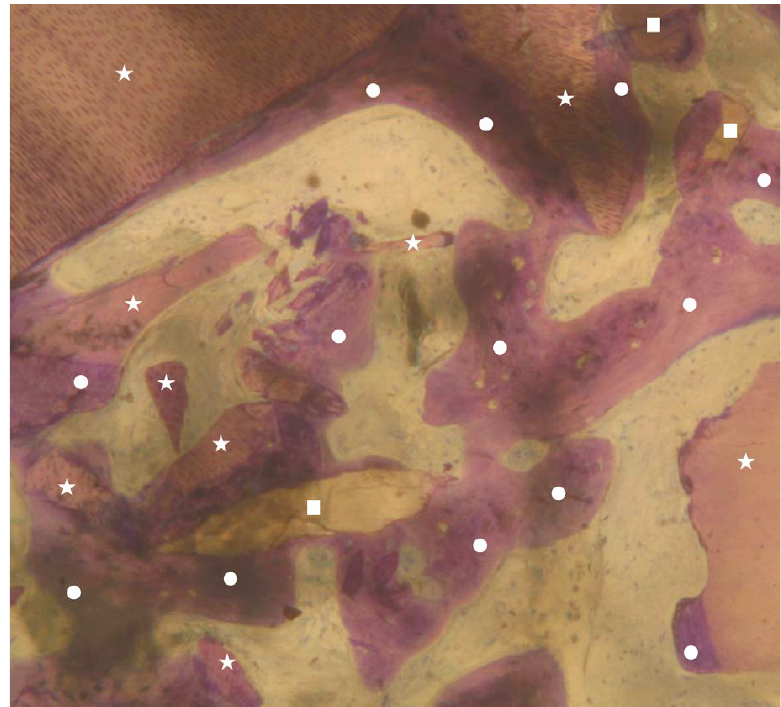
Figure 2. Overview of a biopsy at low magnification. Group 2: dentin matrix granules (indicated by white stars) and enamel granules (indicated by white squares) originating from endodontically treated tooth completely surrounded by newly formed bone (indicated by white circles) are visible. No inflammatory or other adverse reaction is visible around the particles (magnification 8×; toluidine blue).